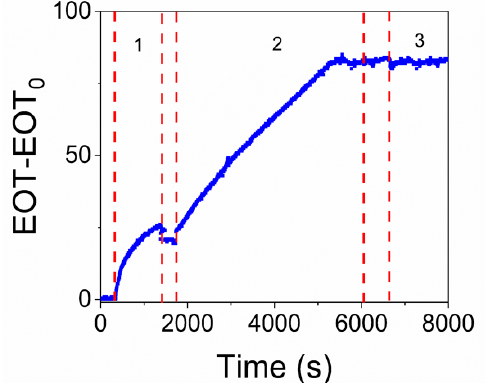
Figure 7. EOT evolution during the sulfo-NHS-biotin ( 1 ), streptavidin ( 2 ) and thrombin infiltration ( 3 ) without TBA.